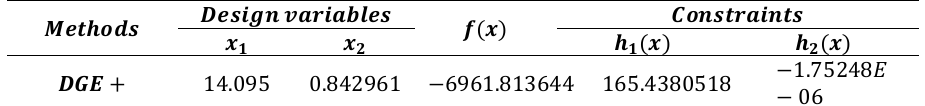
Table 8. Reported result for constrained problem 5 from DEG+